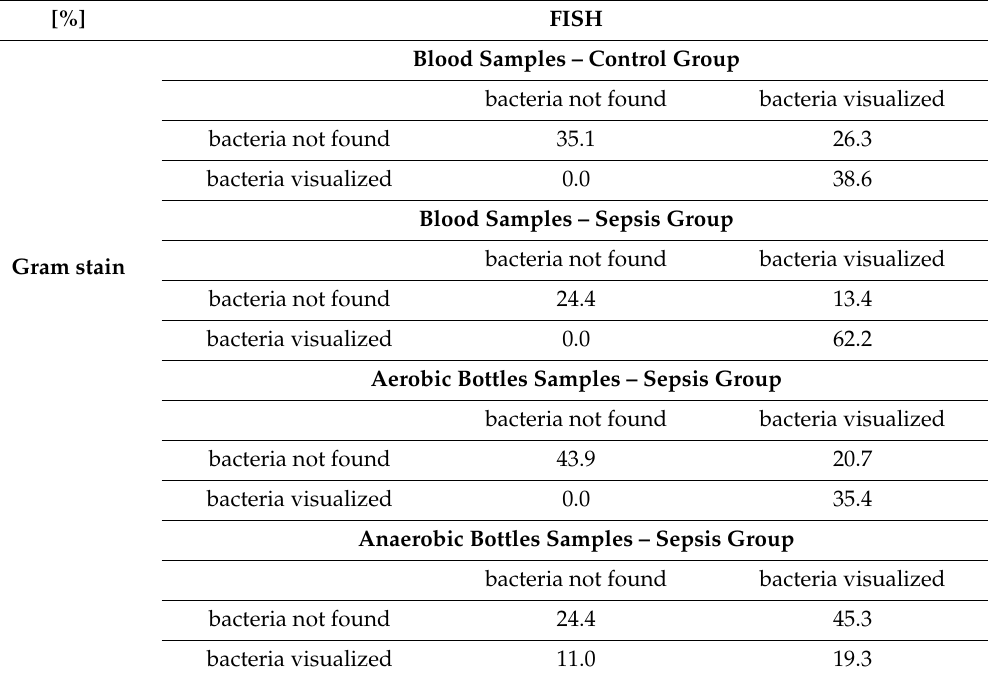
Table 2. Quantitative comparison of positive and negative results obtained by Gram staining and FISH methods for blood samples, aerobic and anaerobic bottles in the group of patients with sepsis and for blood samples in the control